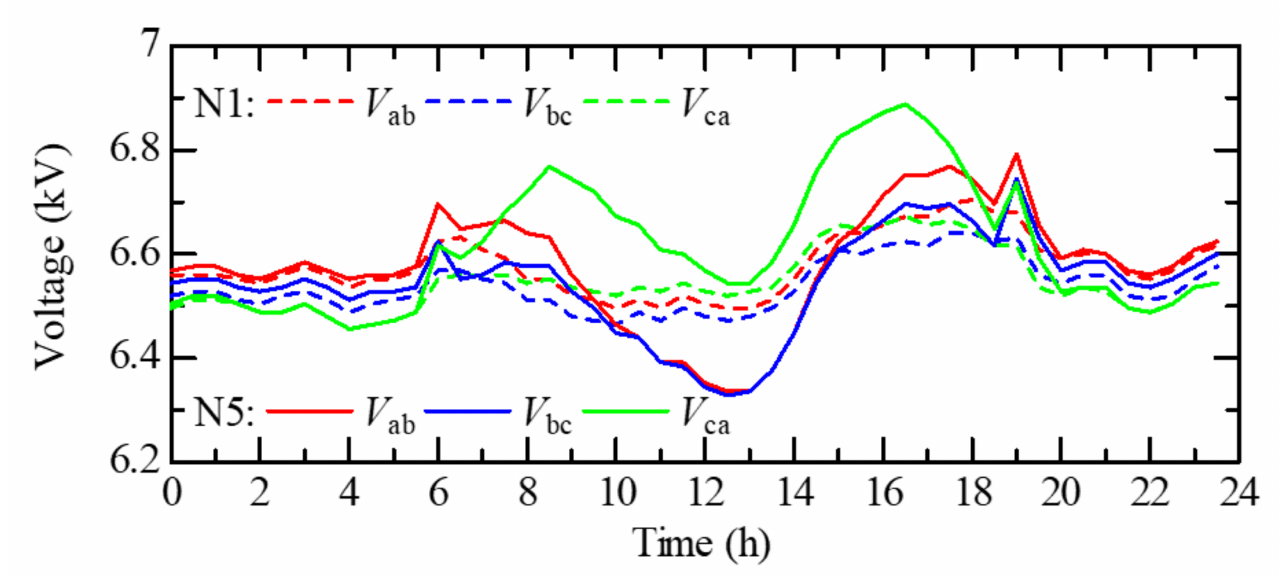
Figure 3. Time variation in the measured voltage in an actual distribution